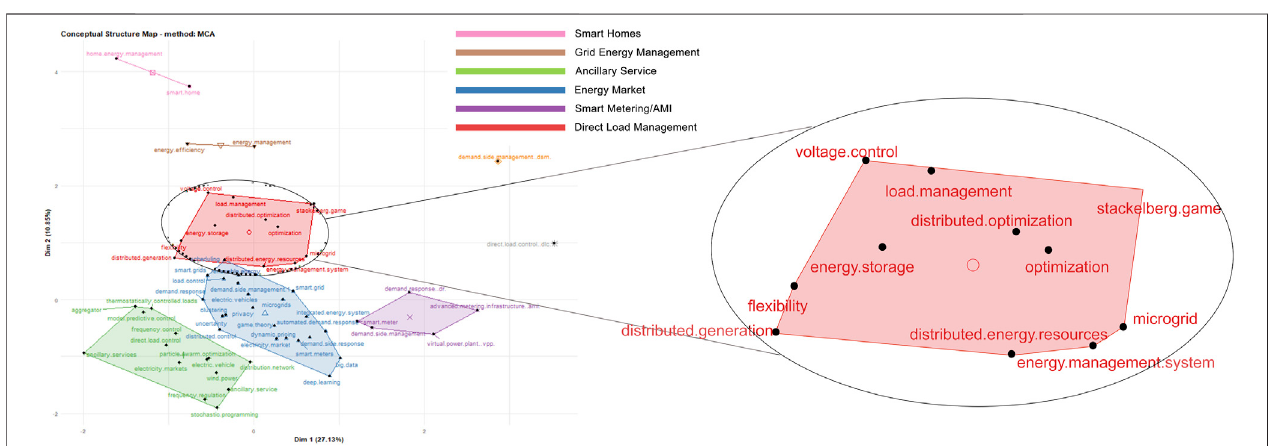
FIGURE 2 | Conceptual structure of demand response research domain by highlighting the research themes found from multiple correspondence analysis (MCA) of the keywords.